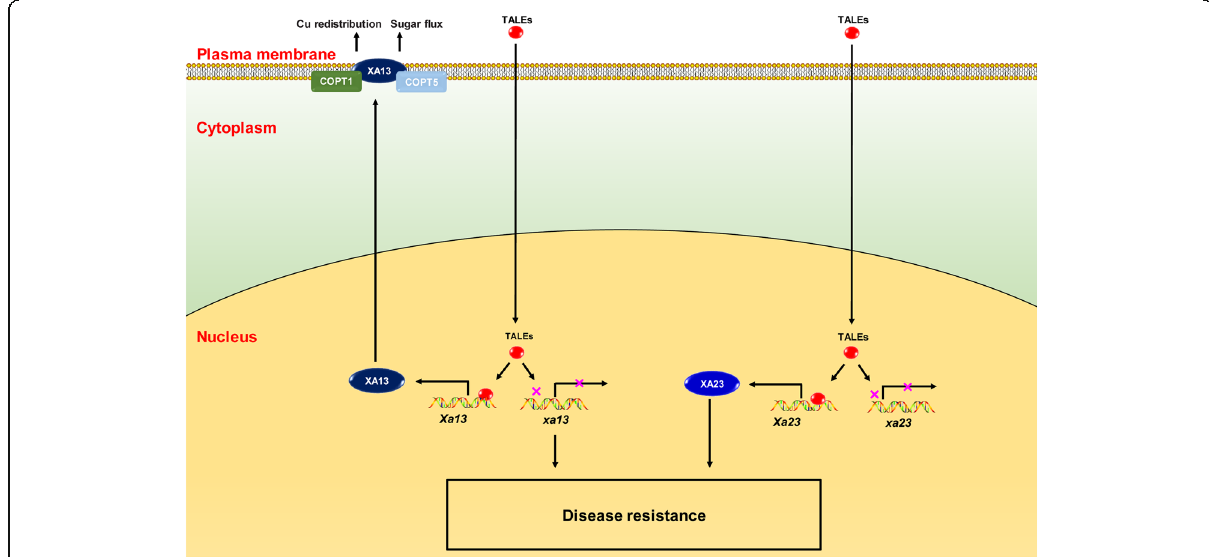
Fig. 3 The SWEET gene xa13 and the executor gene Xa23 mediated immune signaling pathways triggered by Xanthomonas oryzae . The TALEs are secreted into the cytoplasm of plant cells through the type III secretion system, enter the nucleus, bind to the specific promoter elements and induce the expression of Xa13 . XA13 is hijacked by TALEs to export sucrose to the apoplast, which provides nutrition to the pathogen. XA13 is also employed together with COPT1 and COPT5 by TALEs to remove toxic Cu from xylem vessels. The resistant allele xa13 with mutations in the EBEs disrupt the binding of TALEs, leading to disease resistance. Like SWEET genes, the executor R gene Xa23 is transcriptionally activated by TALEs, triggering host defense